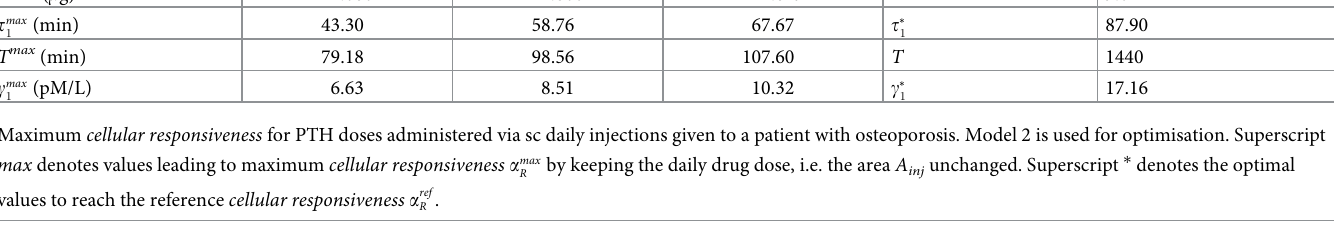
Table 4. Maximum cellular responsiveness for PTH doses administered via sc daily injections. parameter